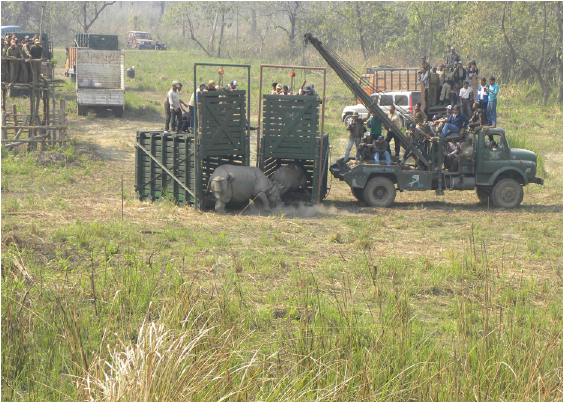
Image 10. Release of Rhino 13, 14 at Manas